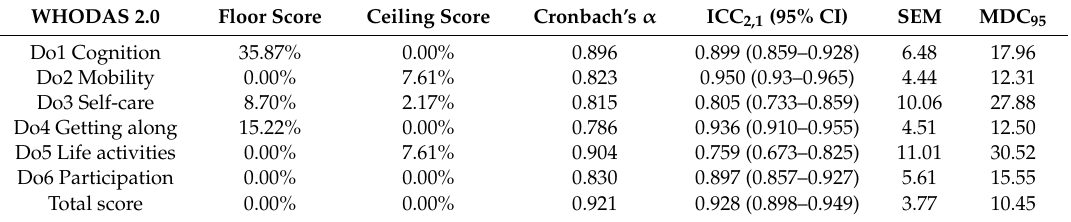
Table 2. Reliability of the 36-item WHODAS 2.0 for patients with LBP.